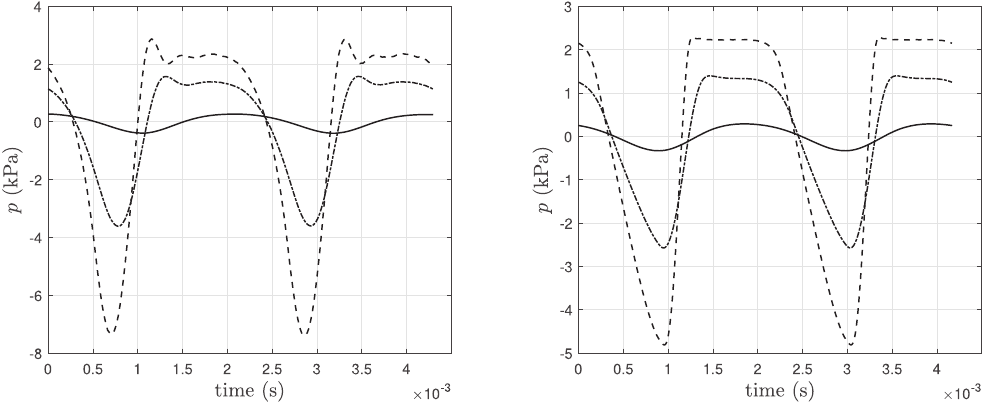
Figure 12. Waveform of p obtained from experimental measurements on a trumpet player (left) and from constrained continuation (right), at p 0 =1 kPa (solid line), p 0 =2 kPa (dashed-dotted line) and p 0 = 3 kPa (dashed